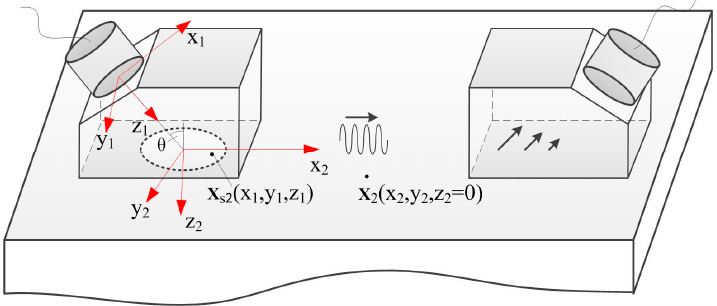
Figure 1. Schematic diagram of angle beam wedge transducers for generating and receiving Rayleigh wave.